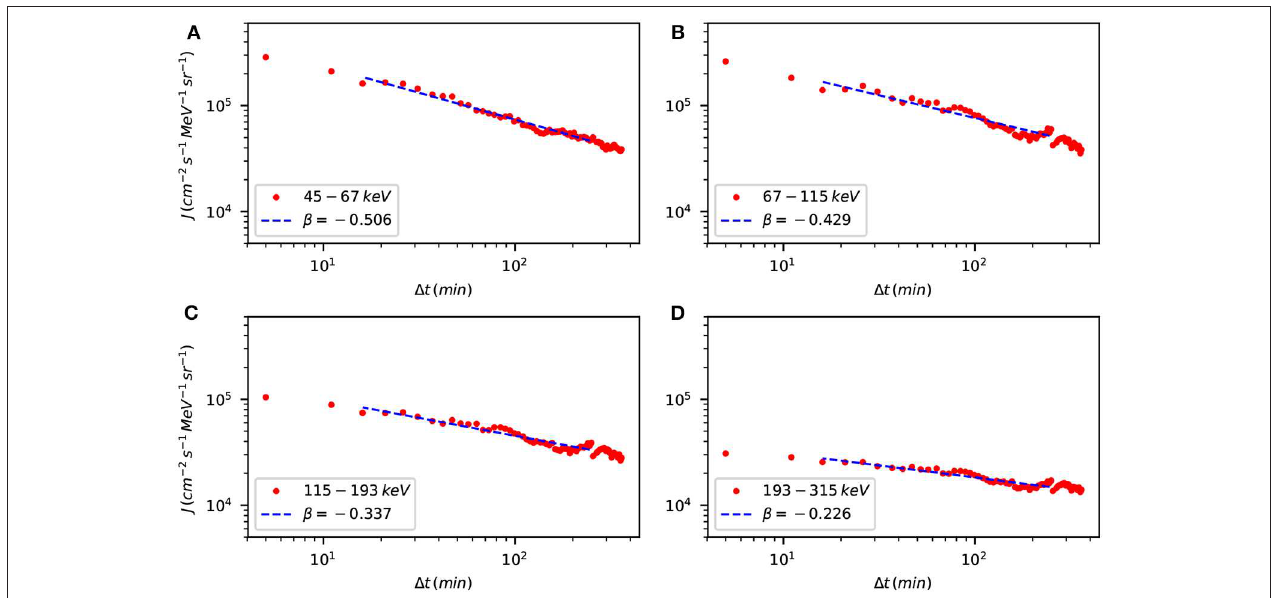
FIGURE 2 | Power-law fits (dashed lines) of the energetic particle fluxes (red dots) in several energy channels, see legends, for the shock crossing of 23 April 2002. The exponent of power-law fit is indicated in legend. The panels correspond to the energy channels (A) 45–67 keV, (B) 67–115 keV, (C) 115–193, and (D) 193–315 keV.